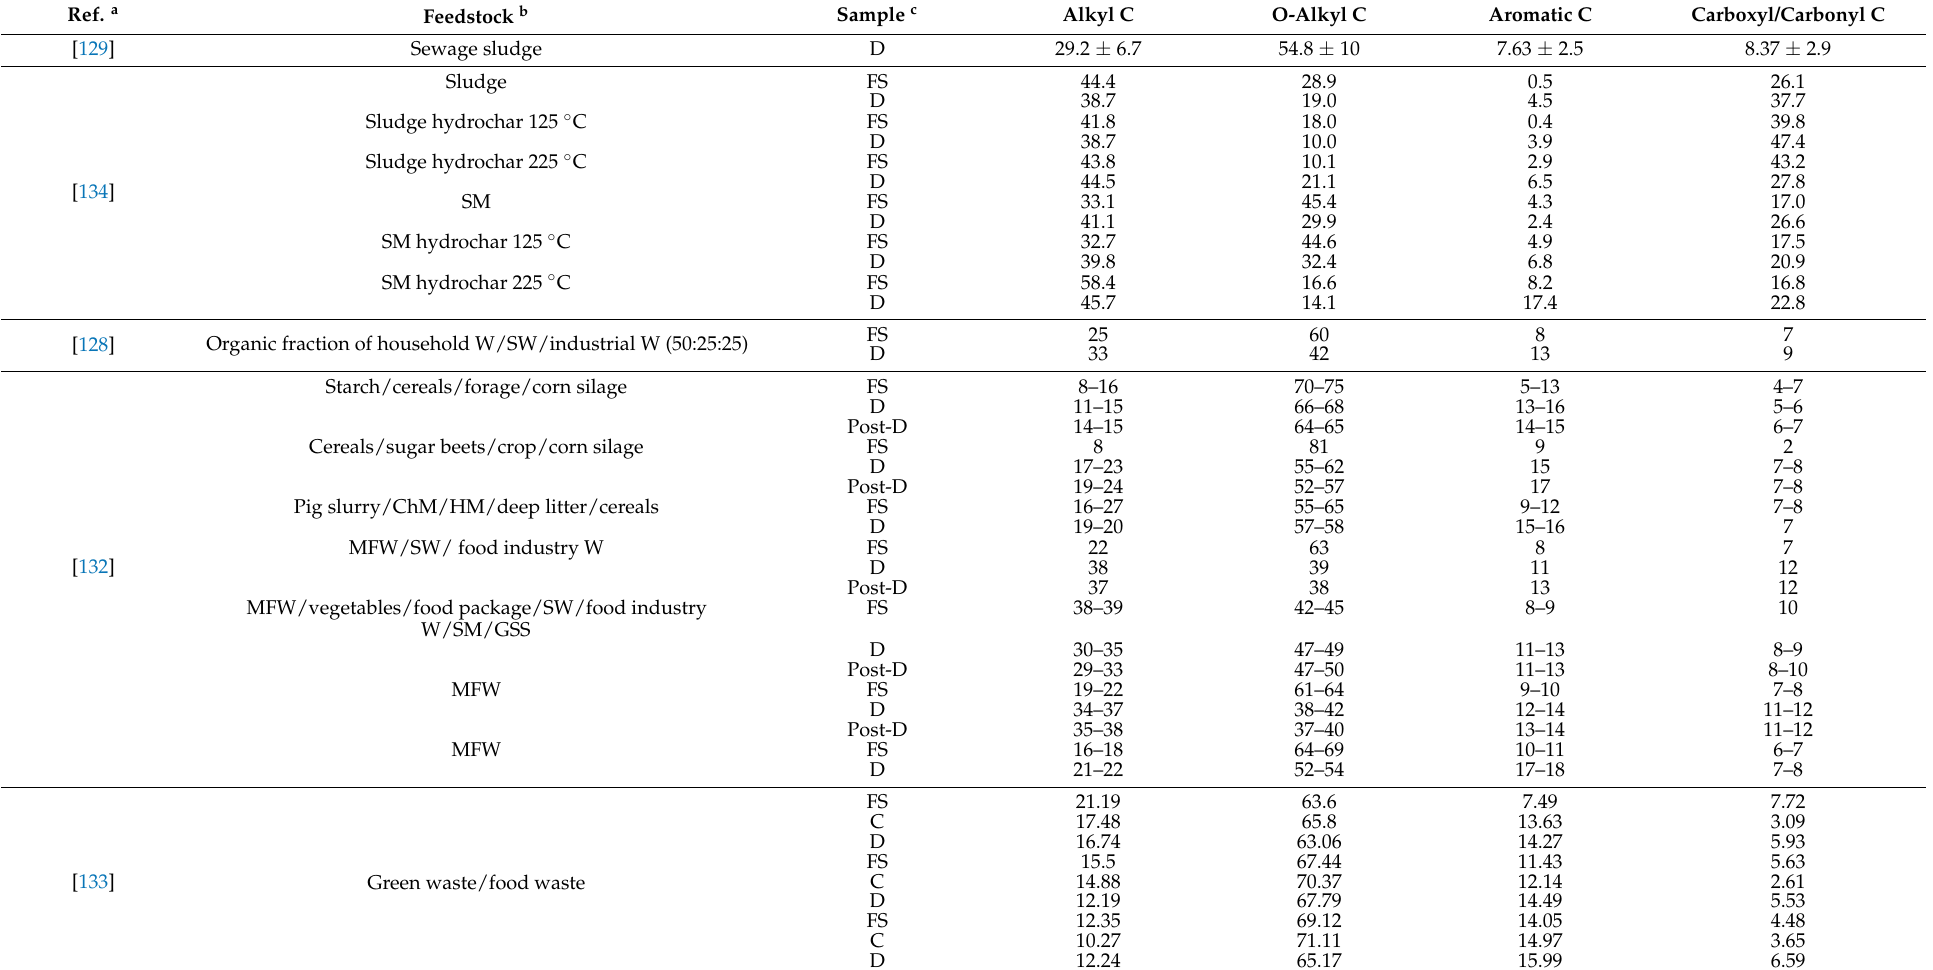
Table 6. Relative areas (% of total area) of the different regions of 13 C CP-MAS NMR spectra for digestate samples and corresponding feedstocks reported in the